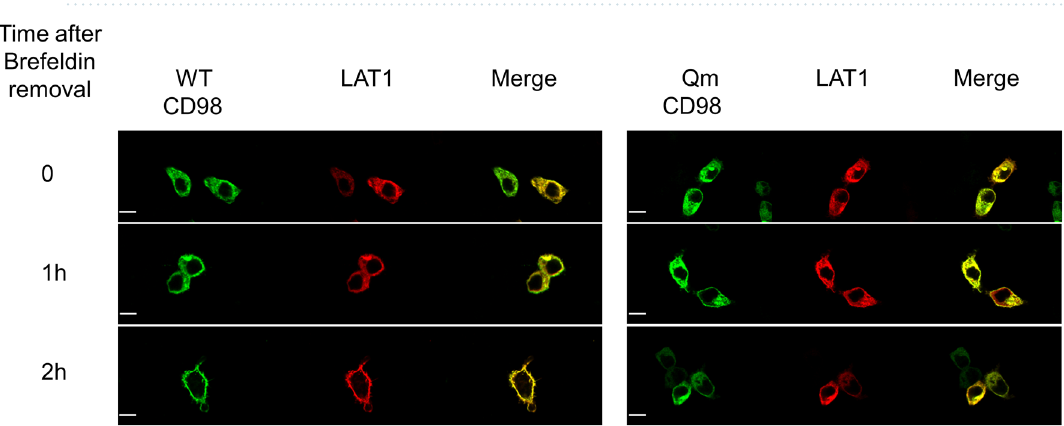
Figure 5. Stability and trafficking from ER to the plasma membrane. In ( A ), transiently transfected HEK293 cells were cultured in the presence of cycloheximide (20 μg/ml) for 0, 2, 4, and 6 h. Then, cells were lysed and analyzed by western blot using anti FLAG-antibody 33 . Anti actin is used as loading control 33 . The western blot image is representative of three independent experiments. The histogram represents mean of values obtained by scanning densitometry of immunoblots; the quantification was performed for WT or Qm comparing each time to the control (time = 0). Data from all experiments are shown in Supplementary Table S1. Significantly differences were estimated by Student’s t-test (a = 3.7E−07, b = 0.00211, c = 2.9E−06, d = 0.00036 and e = 0.000537). In ( B ), HEK293 cells transiently transfected with WT or Qm constructs were treated with 5 μM BFA for 7 h. The treatment blocks the protein trafficking toward the plasma membrane allowing for the retention of CD98 into the ER. The rescue of the protein trafficking was obtained by washing out BFA. Cells were fixed and labeled at the indicated times. Confocal images showed a single, representative, section of a Z-series taken through the entire cell. Scale bar 10 µm.